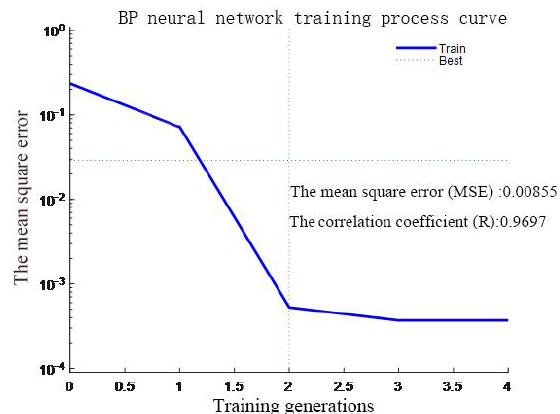
Figure 11. BP neural network training process curve. Table 7. Test values, predicted values, absolute errors and relative errors.